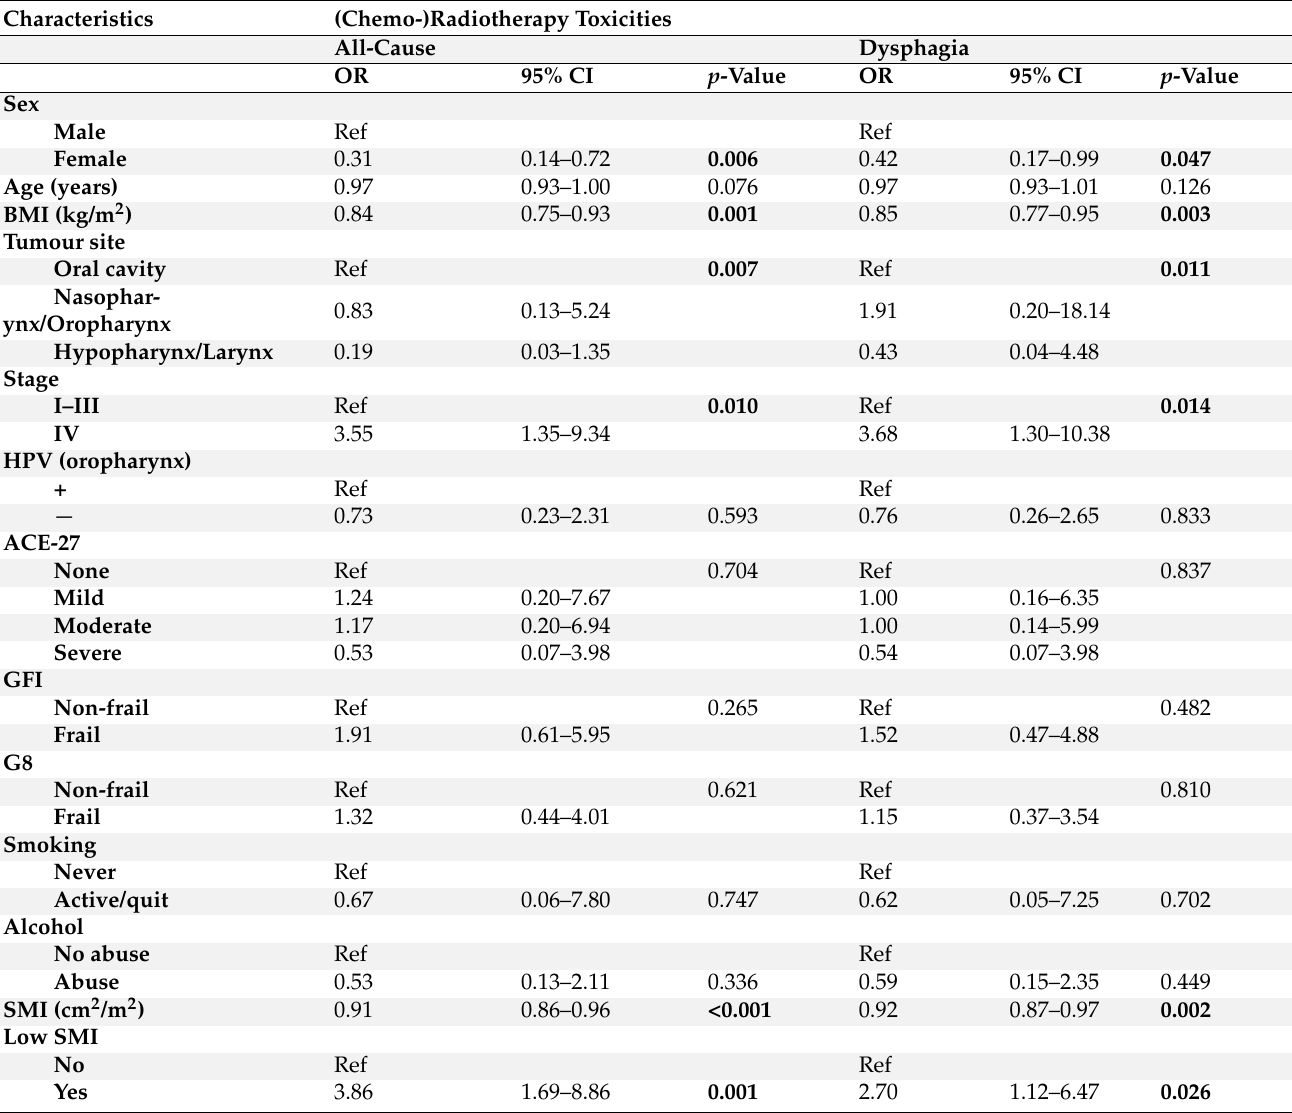
Table 4. Univariable logistic regression for individual predictors of all-cause toxicities and dysphagia toxicity according to CTCAE classification (grade ≥